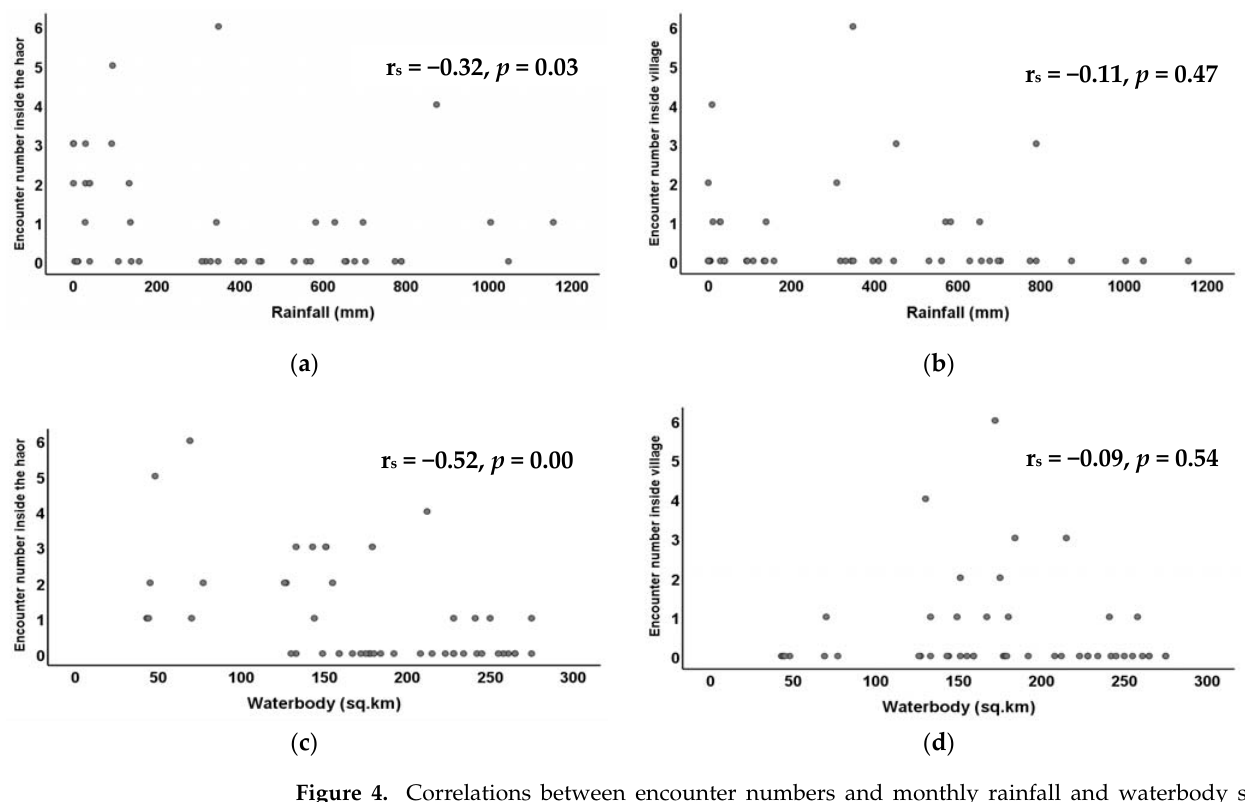
Figure 4. Correlations between encounter numbers and monthly rainfall and waterbody size. ( a ) Encounter numbers inside the haor were negatively correlated with rainfall while ( b ) no significant correlation was found between village encounter numbers and rainfall. Likewise, ( c ) encounter numbers inside the haor were negatively correlated with waterbody size but ( d ) no significant correlation was found between village encounter numbers and waterbody size.